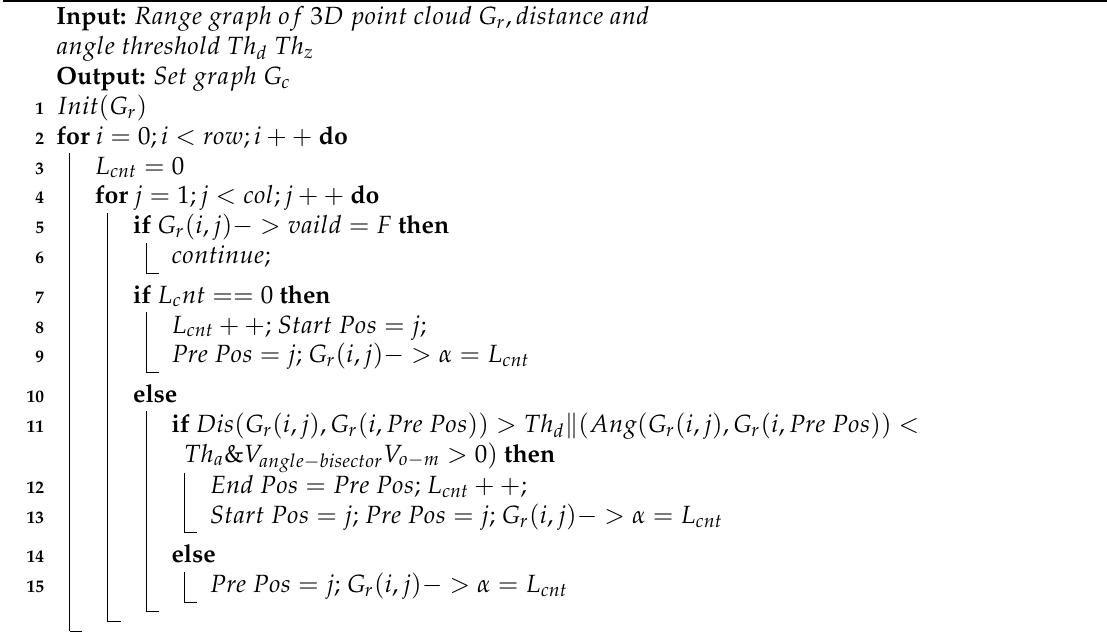
Algorithm 1: First segmentation